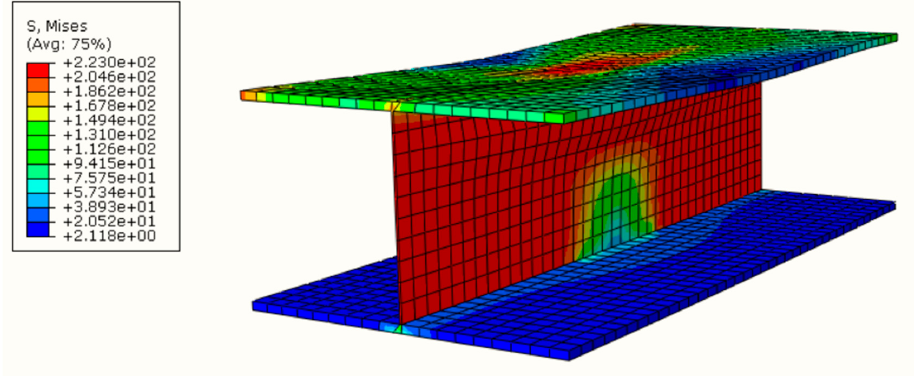
Figure 9. Finite element model of the optimised plate girder with noncompact web .